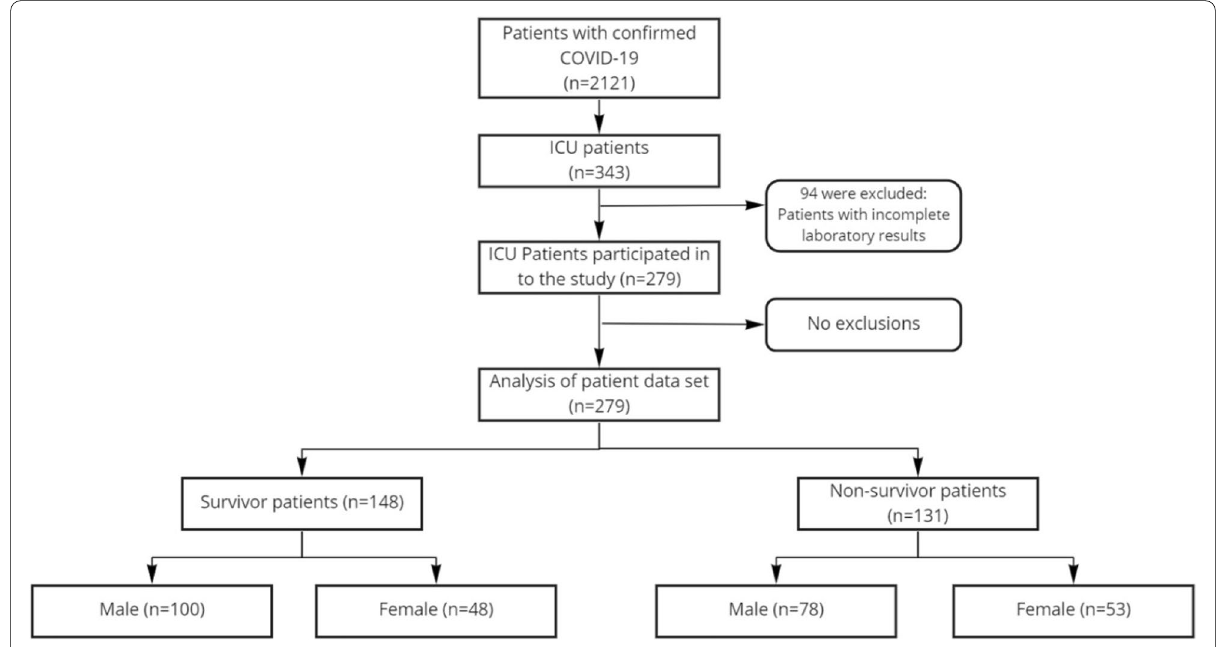
Fig. 1 Patient flow of the